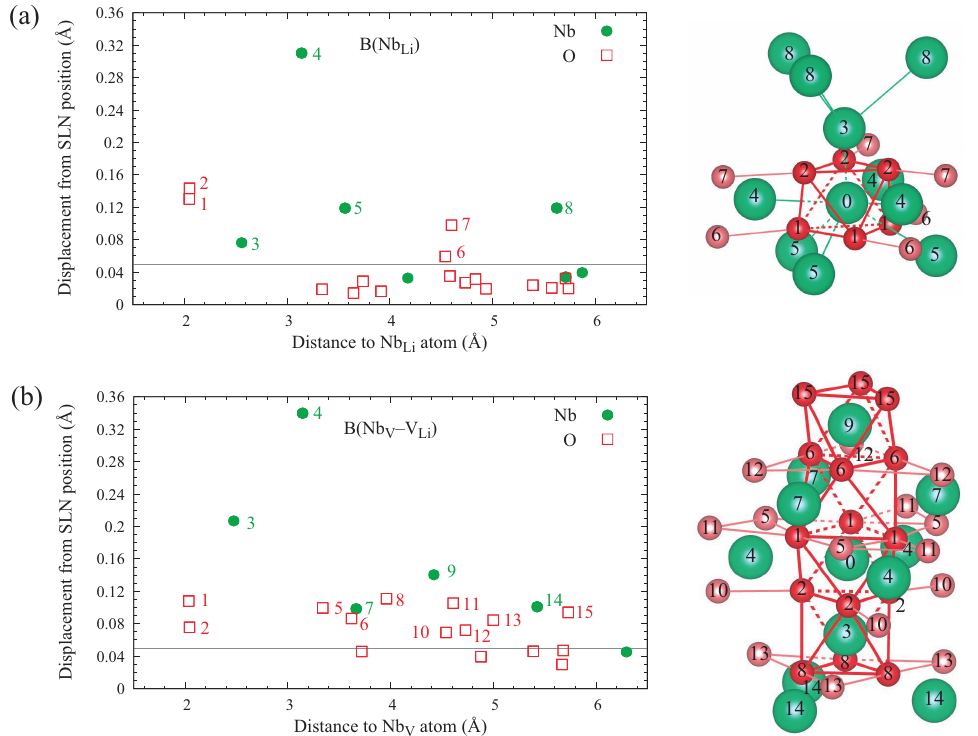
Figure 2. Atomic displacements in the vicinity of a bipolaron at the Nb Li antisite defect ( a ) or the Nb V –V Li defect pair ( b ) with respect to the positions in stoichiometric LN, plotted as a function of the distance from the defect niobium atom hosting the bipolaron. Green circles and red boxes refer to niobium and oxygen atoms, respectively. The numbering corresponds to the pictured section of the crystal structure, the label “0” marks the defect Nb Li or Nb V atom hosting the bipolaron. Large green and small red balls represent niobium and oxygen atoms, respectively. Oxygen atoms outside the central pillar of oxygen octahedra are indicated in a lighter color